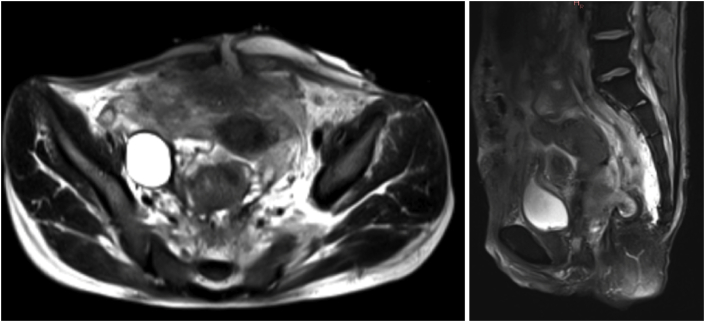
Abdominal MRI - A poorly-dissociable conglomerate of ileal loops was also described, specially involving the pelvic and terminal ileum, with widespread thickening and enhancement of the mesentery, due to phlogosis, and several entero-enteric/entero-mesenteric fistulas.